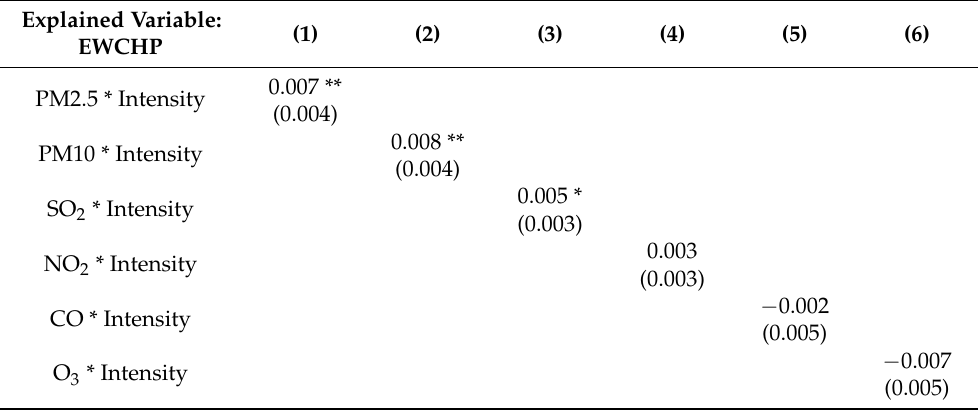
Table 8. Moderating effects of regional environmental